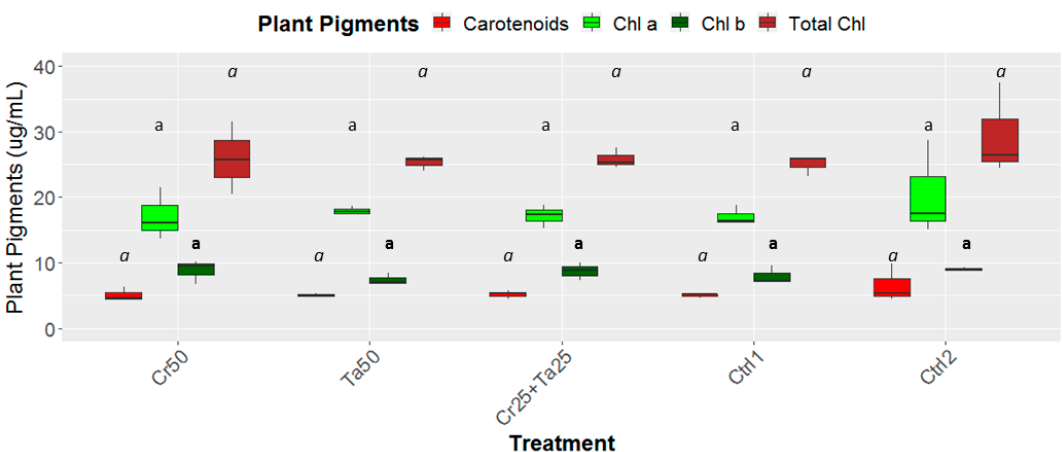
Figure 8. E ff ects of Ta and Cr, either applied individually or in consortium on the leaf chlorophyll as well as carotenoid contents and total chlorophylls for oil-palm seedlings at 5 months post-inoculation (MPI). Treatments abbreviations: Cr50—inoculated with 50 g of C. rosea AAB0114 ( Cr ); Ta50—inoculated with 50 g of T. apiculatus AAT0115 ( Ta ); Cr25 + Ta25—inoculated with 25 g of Cr and 25 g of Ta ; Control 1—only the uninoculated blended maize was applied; and Control 2—without the uninoculated blended maize. Means of the four di ff erent plant pigments, namely chlorophyll a (Chl a), chlorophyll b (Chl b), carotenoids and total chlorophylls (Total Chl) were analyzed separately. Means with the